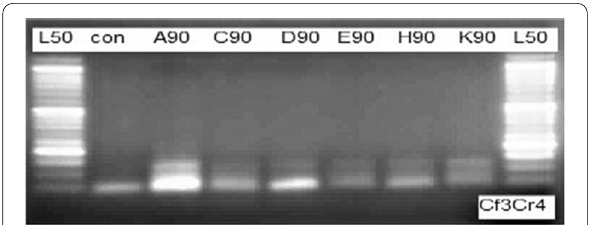
Fig. 6 PCR amplification of Cf3Cr4 in some blood samples of rats fed on GM‑diet for 90 days. Cf3Cr4 (123 bp‑target) is another segment from CaMV promoter, (con) is a negative control (0‑day